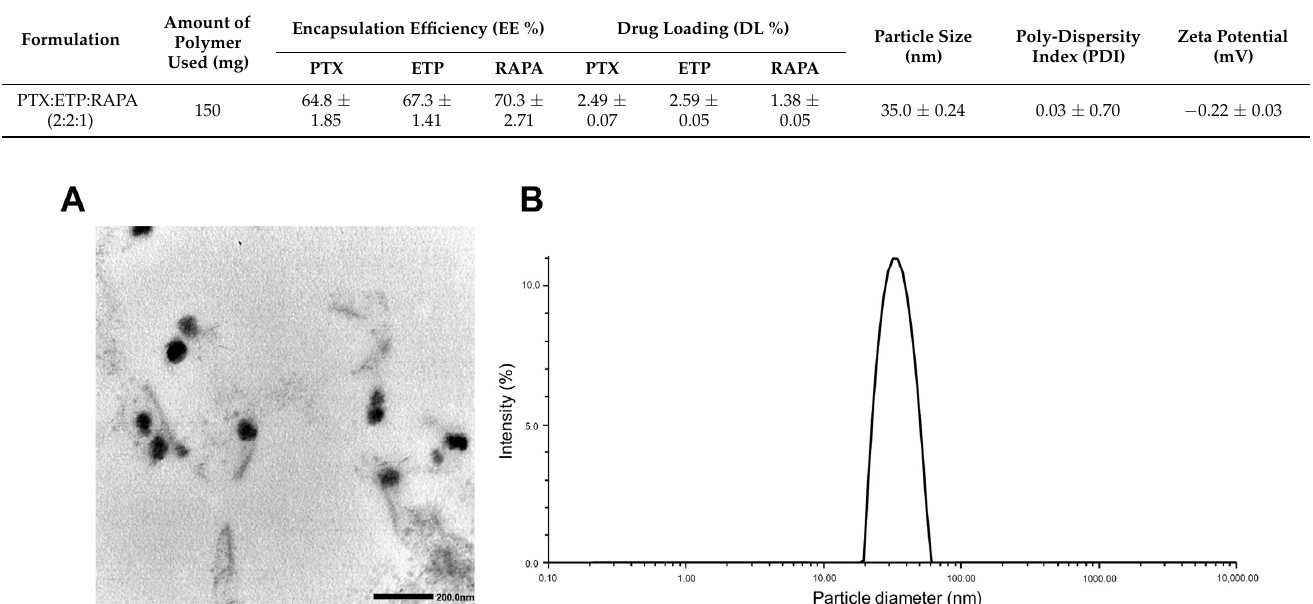
Figure 2. ( A ) Transmission electron microscopy (TEM) image of PTX/ETP/RAPA-loaded mPEG-pH- PCL micelles. ( B ) Representative particle size distributions of PTX/ETP/RAPA-loaded mPEG-pH- PCL micelles (n = 3). Table 2. Physicochemical characterization of paclitaxel (PTX), etoposide (ETP), and rapamycin (RAPA)-loaded mPEG-pH-PCL micelles (n = 3).